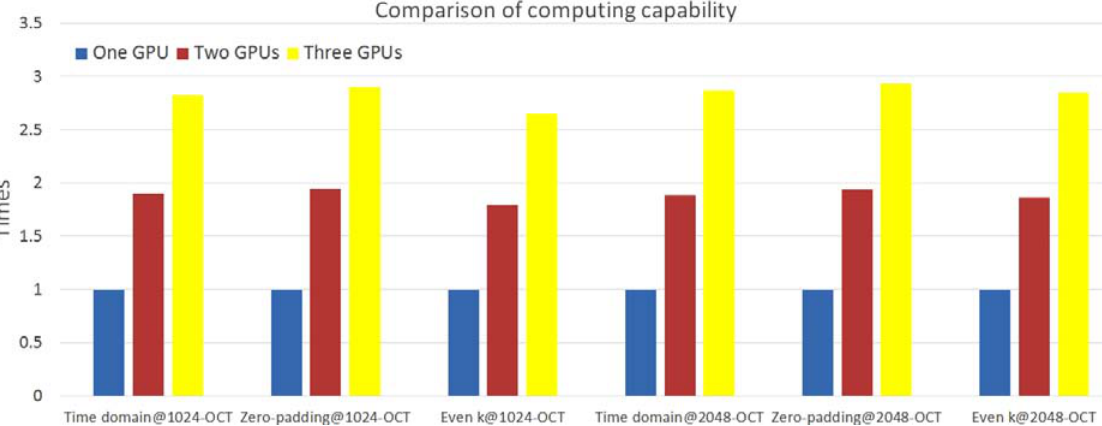
Fig. 5. Comparison of computing